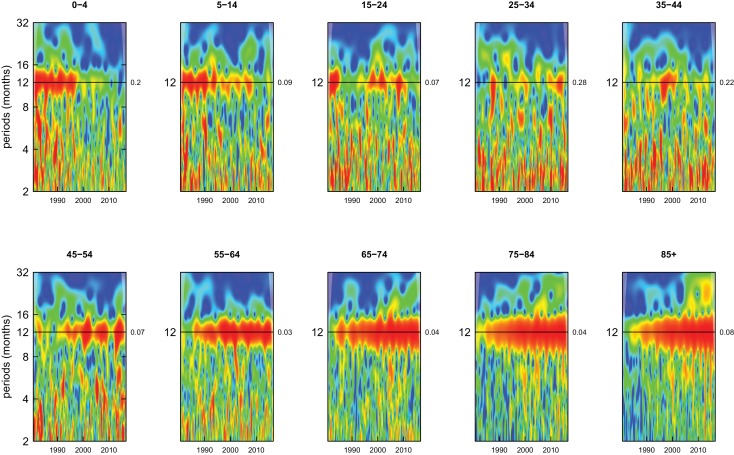
Wavelet power spectra for national time series of neuropsychiatric disorder death rates for 1980–2016, by age group for males.Wavelet power values increase from blue to red. The shaded regions at the left and right edge of each box indicate the cone of influence, where spectral analysis is less robust. P-values for the presence of 12 month seasonality are to the right of each figure at the 12 month line.